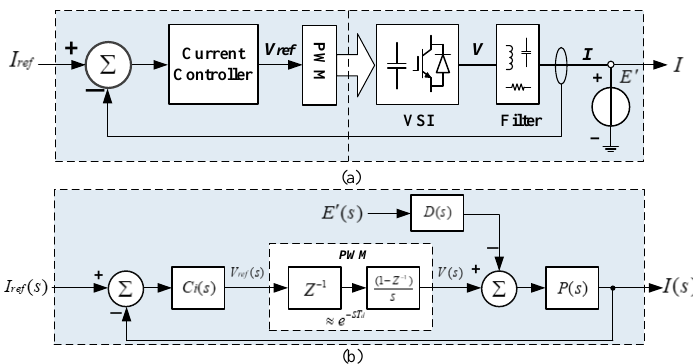
Figure 4. Control system of an inverter. ( a ) Simplified block diagram; ( b ) Schematic diagram.